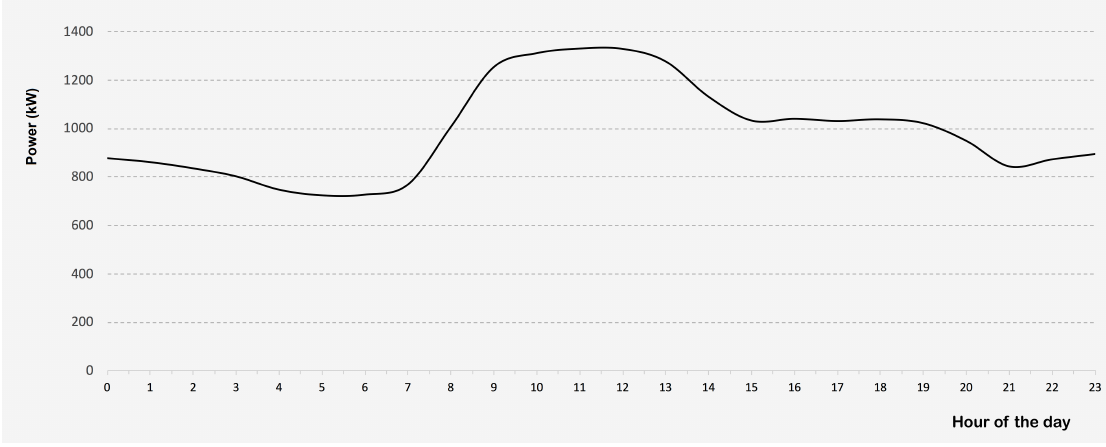
Figure 4. Average day electric load curve of the university analyzed (year 2018).